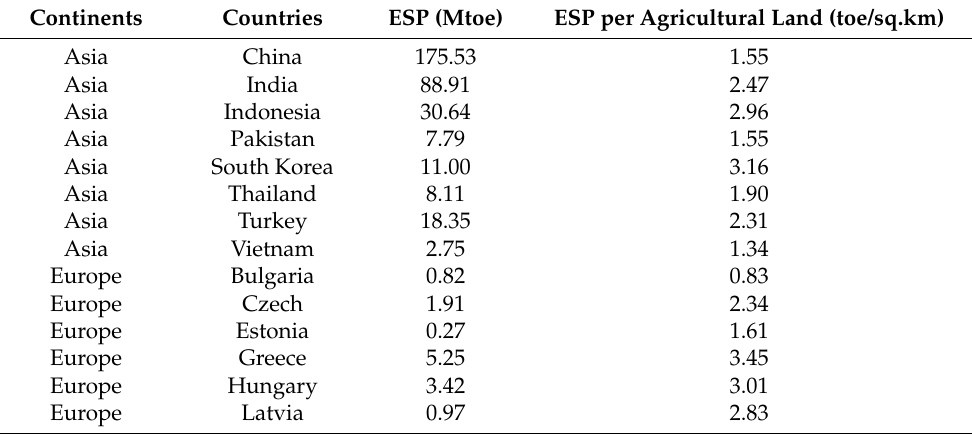
Table 4. Energy-saving potential in the agricultural sector of emerging economies